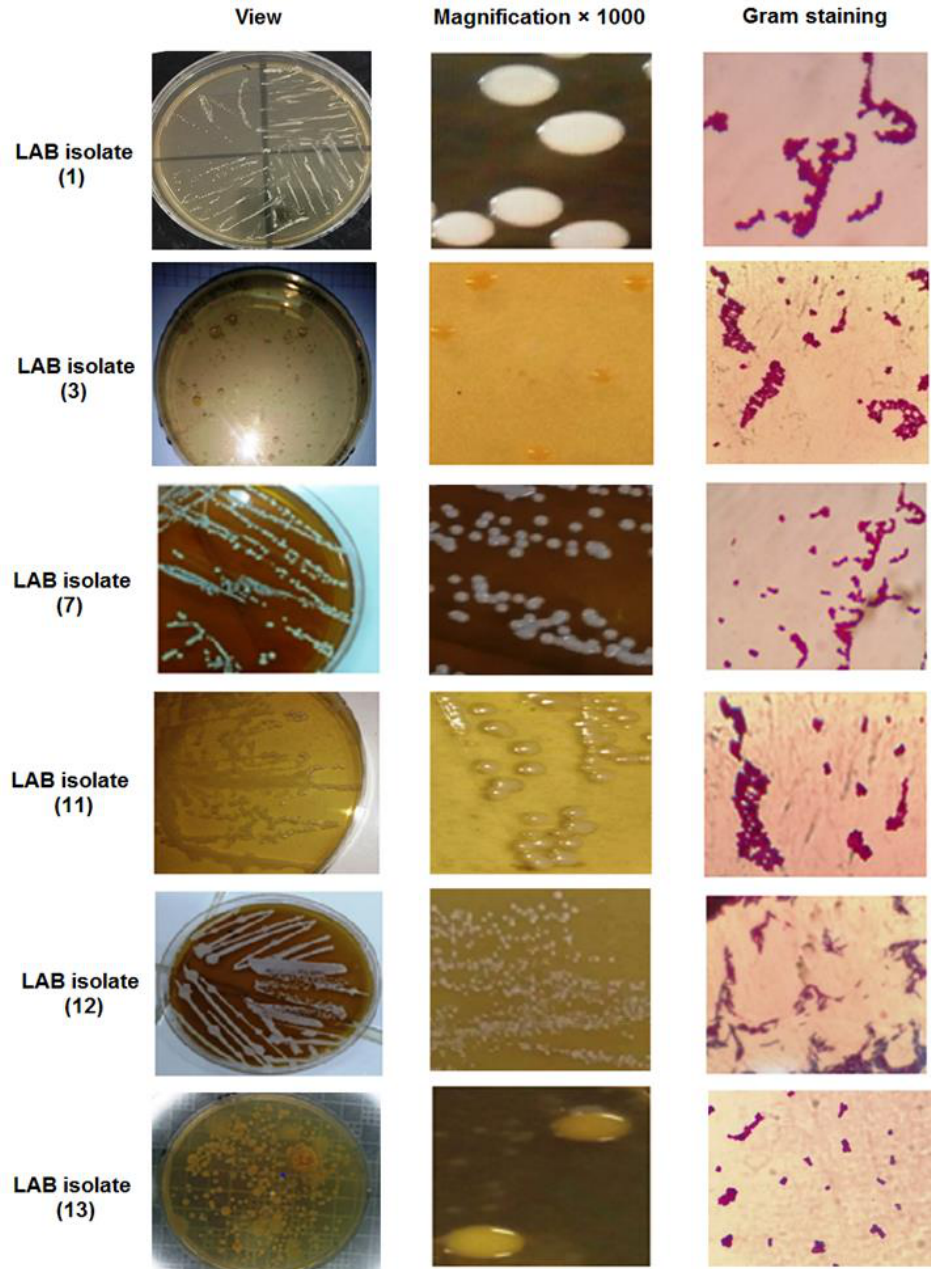
Figure 2. Characteristics of the colonies and microscopic view ( × 1000) of the LAB isolate after Gram staining.